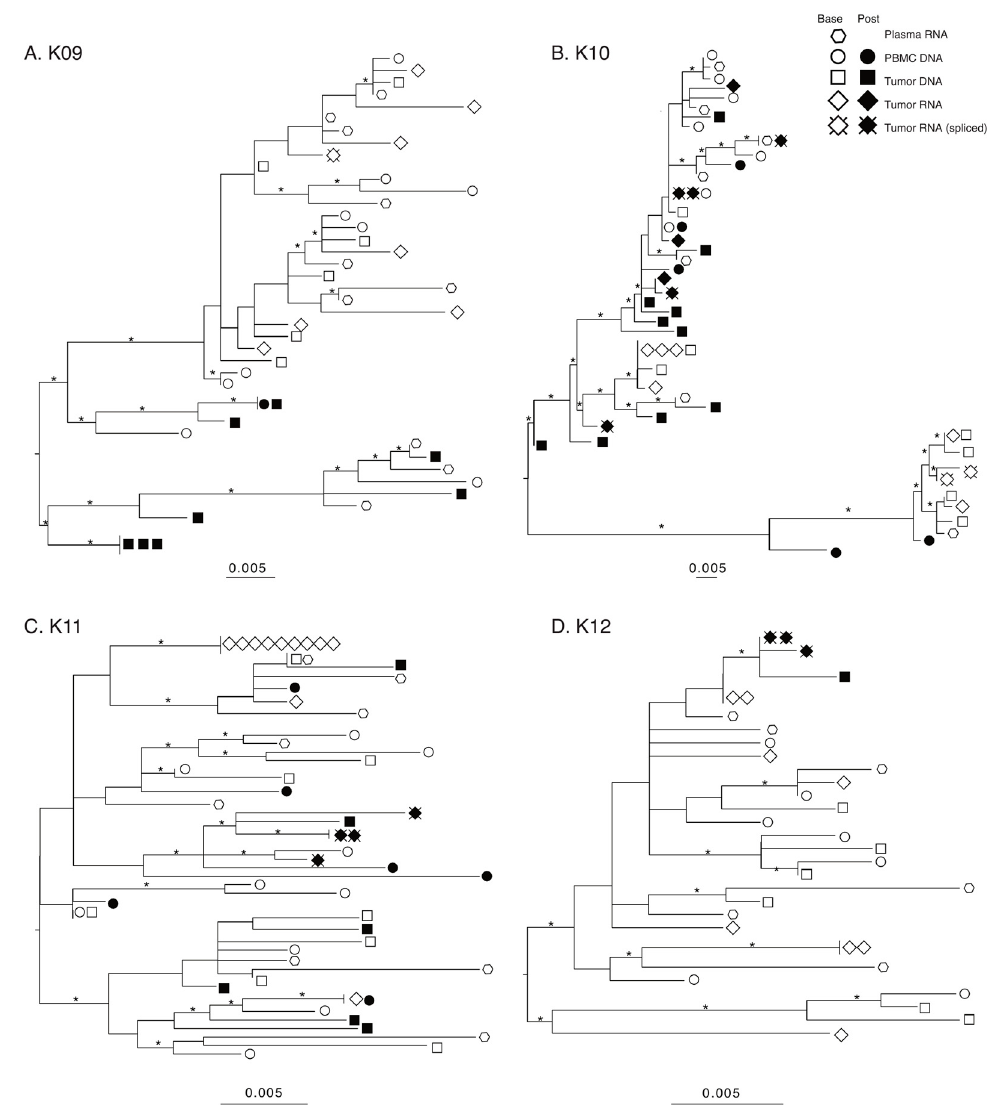
Figure 2. Maximum-likelihood (ML) phylogenies of nef sequences. Phylogenies for each patient were estimated using IQ-TREE2 under a general-time-reversible (GTR) nucleotide substitution model and gamma-distributed rate variation among sites. Statistical support of branches was assessed with 1000 bootstrap replicates and branches with 75% or more support are denoted with an asterisk. Phylogenies were visualized and midpoint rooted using FigTree.